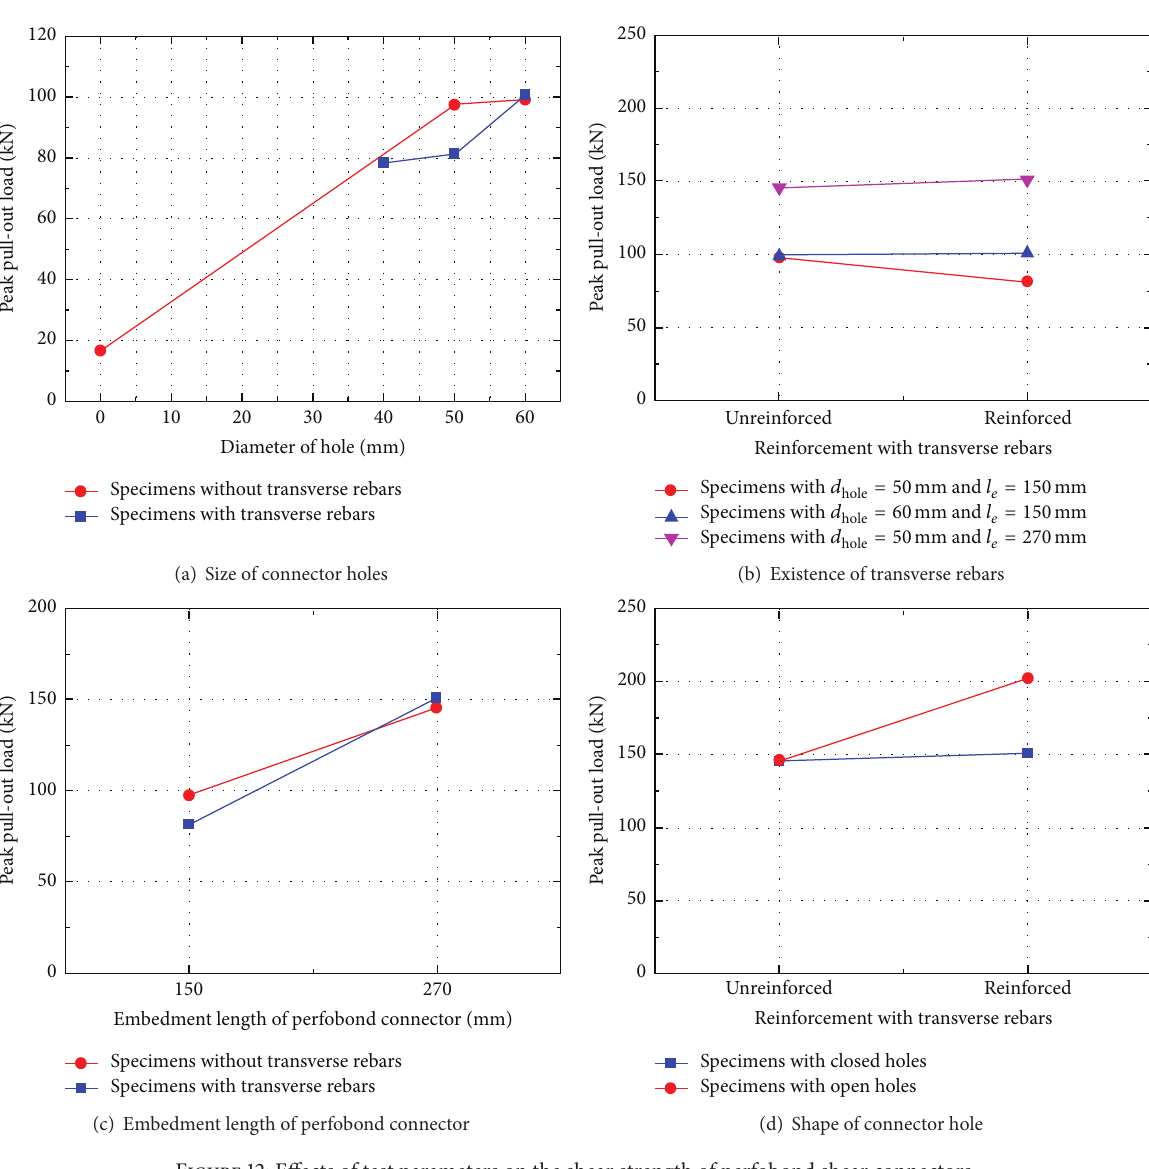
Figure 12: Effects of test parameters on the shear strength of perfobond shear